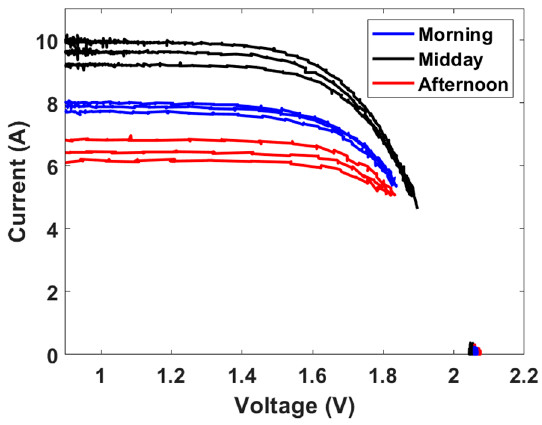
Figure 3. Experimental I–V curves collected from the bifacial minimodule in one of the days of measurements.